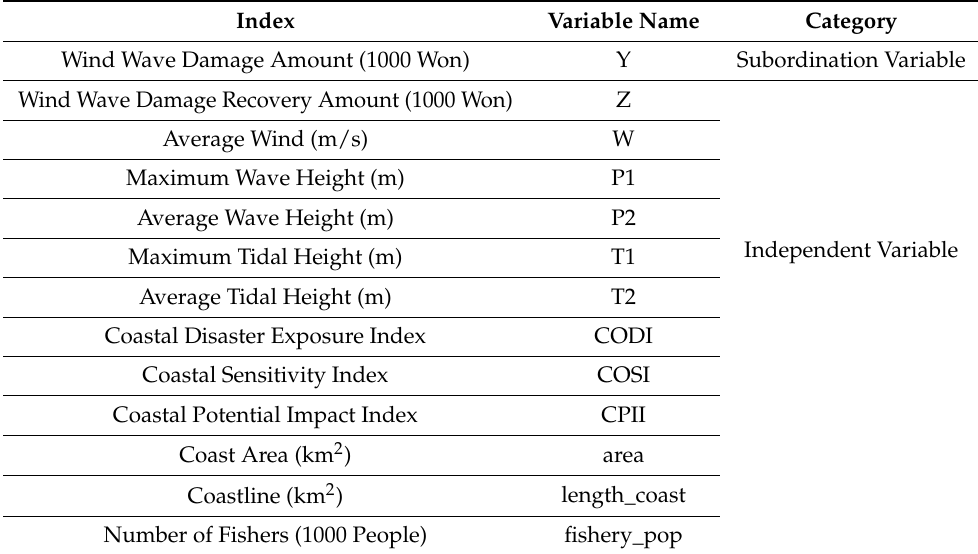
Table 2. Variable